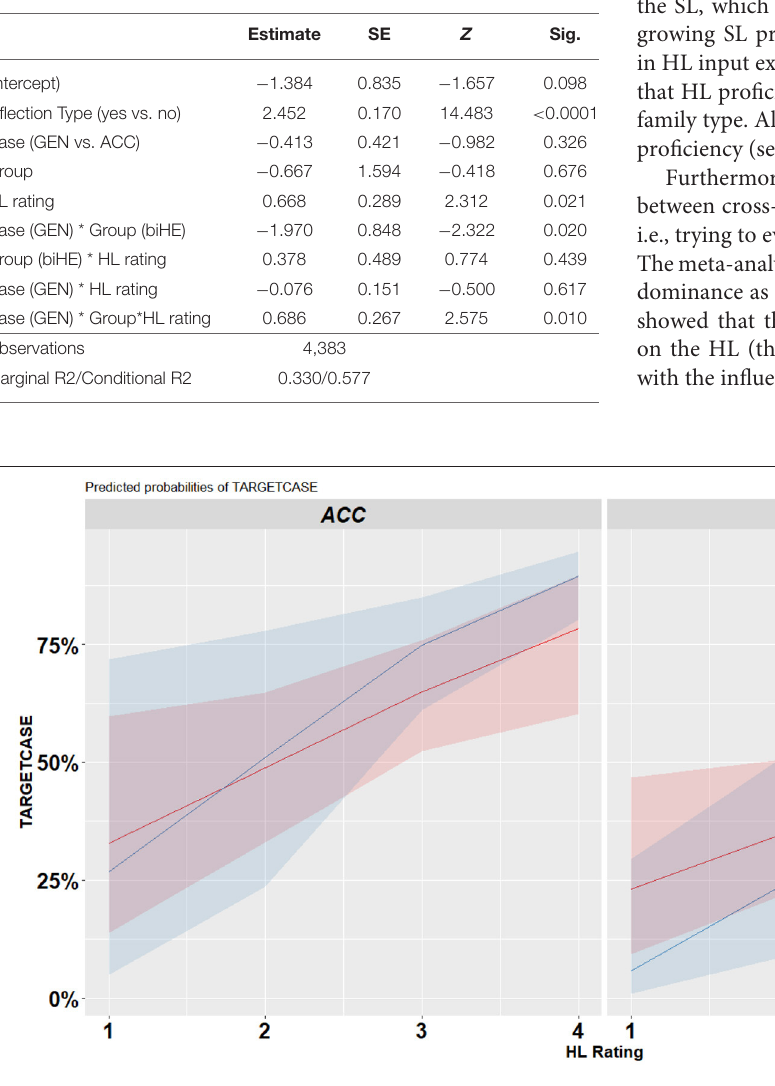
FIGURE 6 | Predicted case production by case by group by HL